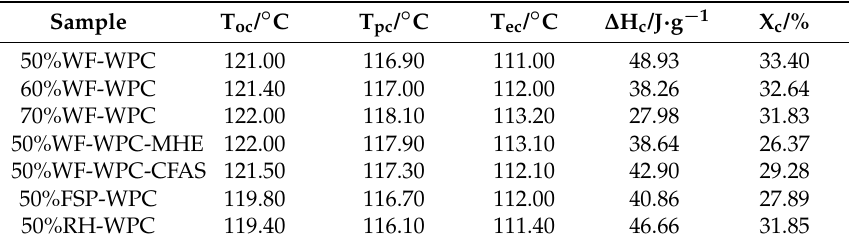
Table 4. Characteristic data of the WPCs’ crystal